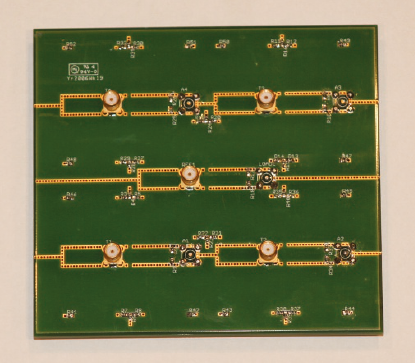
Figure 16: A photograph of the transceiver side of the calibration coupler board. The opposite side connects to the antenna array and acts as the ground plane.